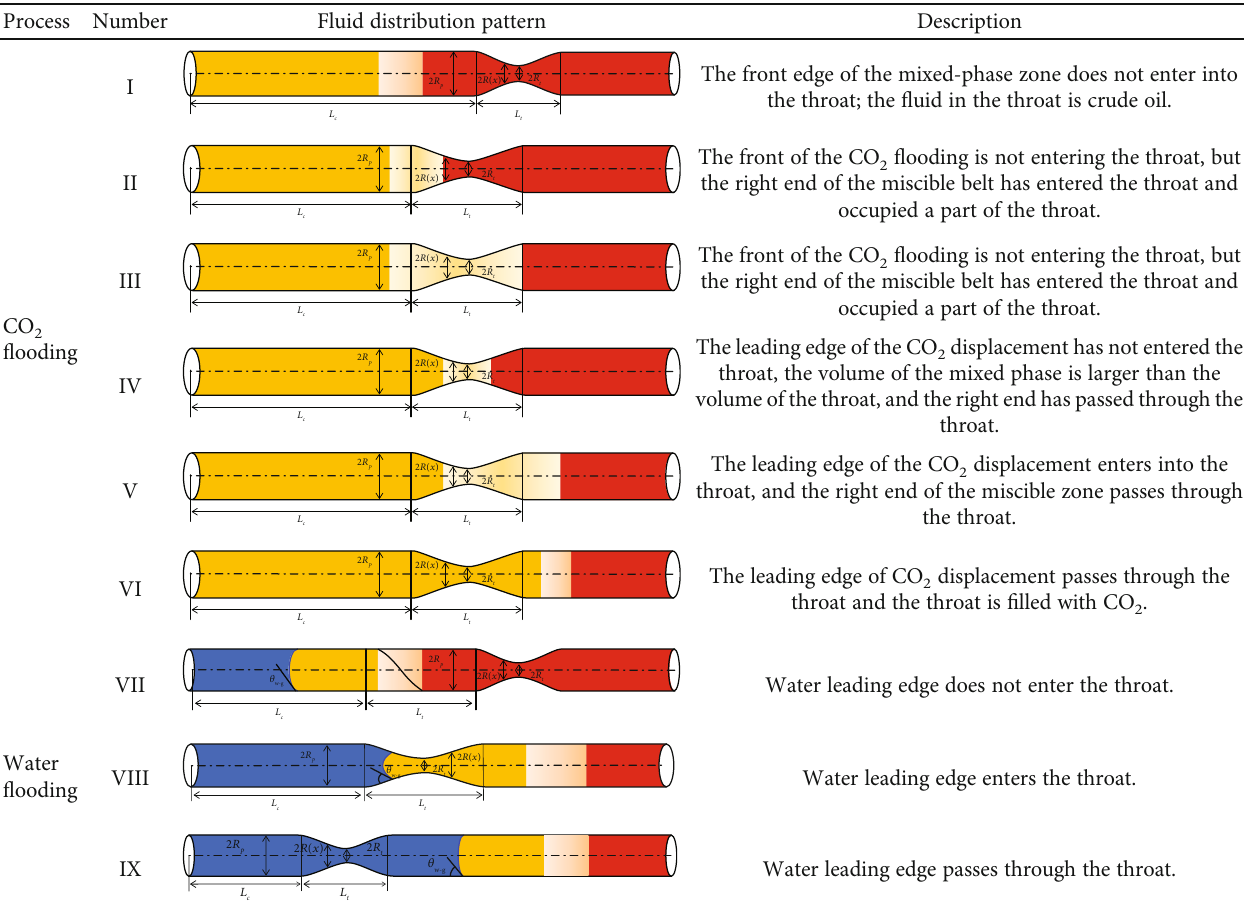
Table 1: Schematics for fl uid distribution pattern during CO